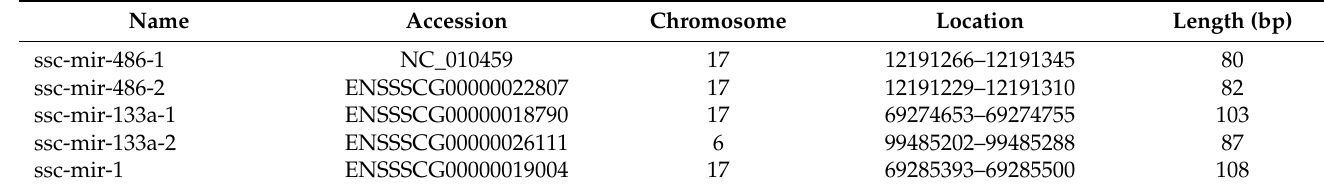
Table 2. The precursor information of ssc-miR-486, ssc-miR-133a-3p and